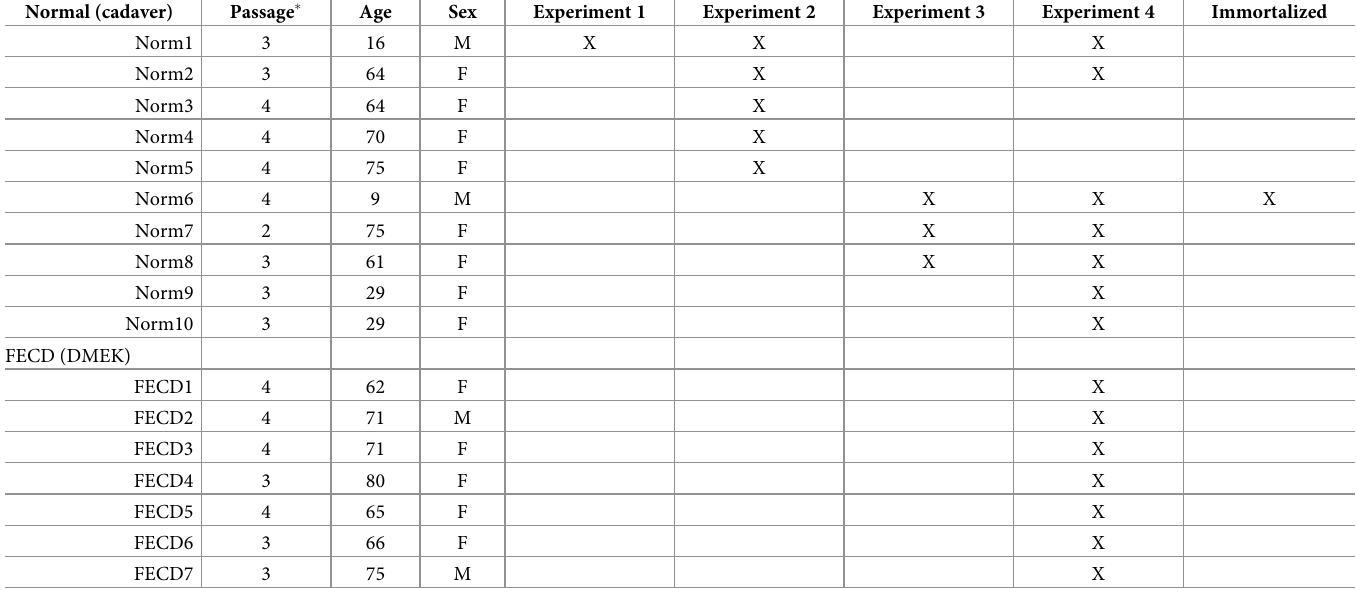
� Passage number at time of